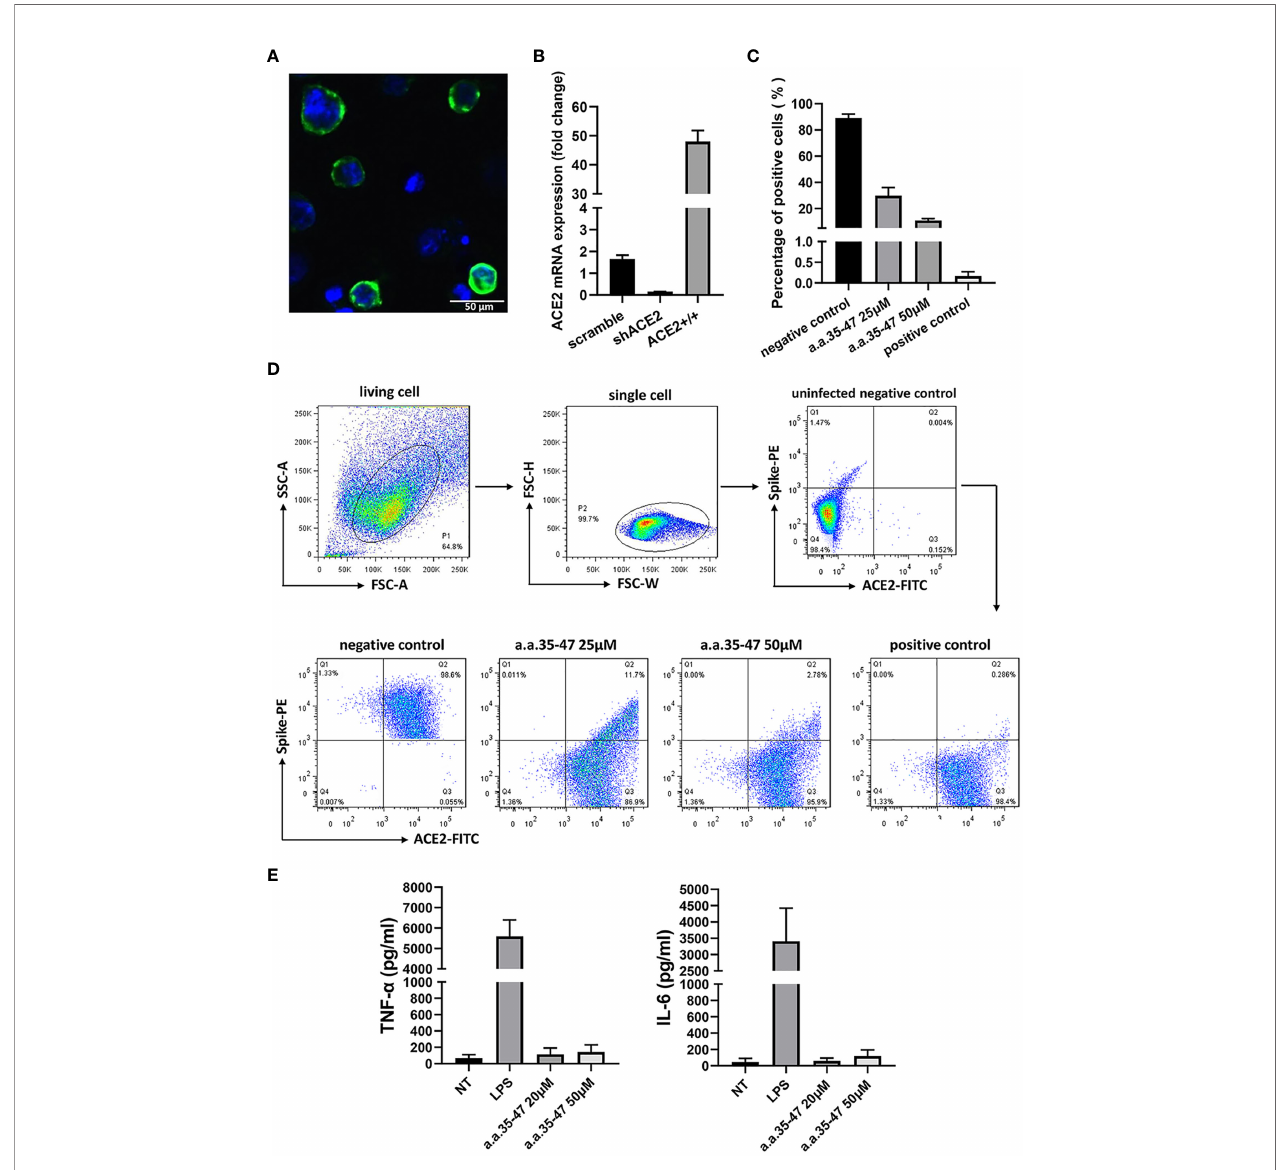
FIGURE 5 | CBS inhibits the spike RBD from binding to cell surface ACE2. (A) Immuno fl uorescence of the A549 cells stably expressing ACE2. Green fl uorescence indicates ACE2-mNEOGreen and blue indicates DAPI. (B) mRNA expression of ACE2-overexpressing (ACE2+/+) and knockdown (shACE2) cell lines (n = 3). (C) Results of fl ow cytometry showing that CBS inhibits the interaction between the spike RBD and ACE2 at the cellular level (n = 3). Lome fl oxacin acted as the positive control and untreated cells served as the negative control. (D) Schematic showing the fl ow cytometry gating process and typical fl ow cytometry diagrams of different concentrations of CBS-treated cells and controls. (E) CBS itself did not induce the release of cytokines from immune cells. Immortalized bone marrow-derived macrophages (iBMDM) were stimulated with different concentrations of CBS, and lipopolysaccharide (LPS) was used as the positive control (n = 3). Results showed that the CBS itself did not stimulate cells. All results are presented as means ±